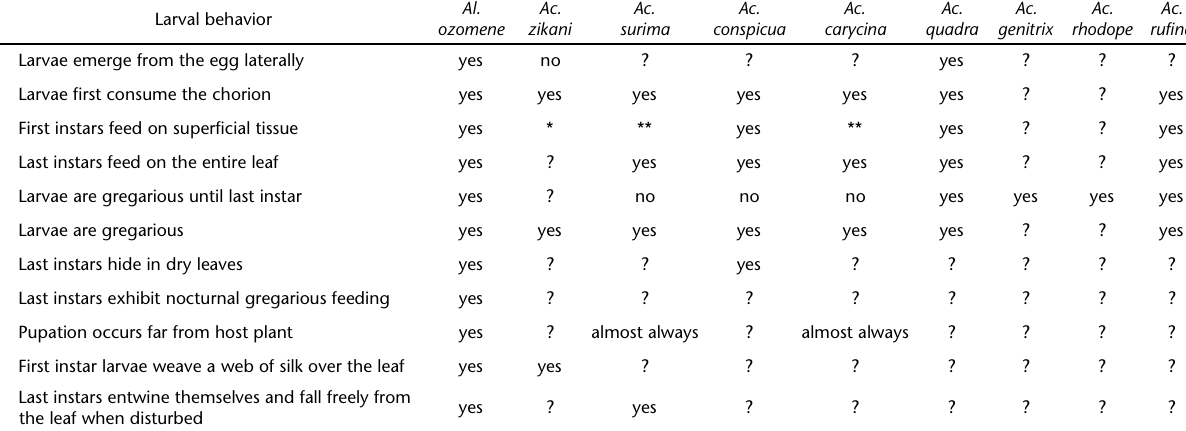
Table IV. Larval behavior of Altinote ozomene (this study) and six species of Actinote (P ALUCH et al. 1999, 2001, 2005, F RANCINI et al. 2005, and F REITAS et al. 2009a, b, 2010). Larval